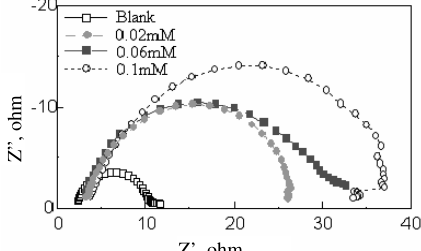
Figure 4. Polarization curves for mild steel recorded in 1 M H concentrations of inhibitor